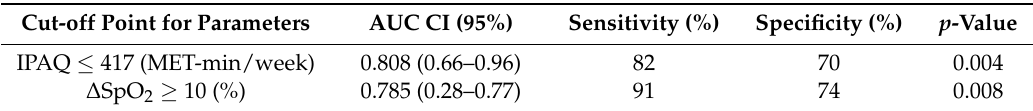
Table 2. Cut ‐ off points of physical activity and exertional desaturation predicting mortality in patients with idiopathic pulmonary fibrosis. Cut ‐ off Point for Parameters